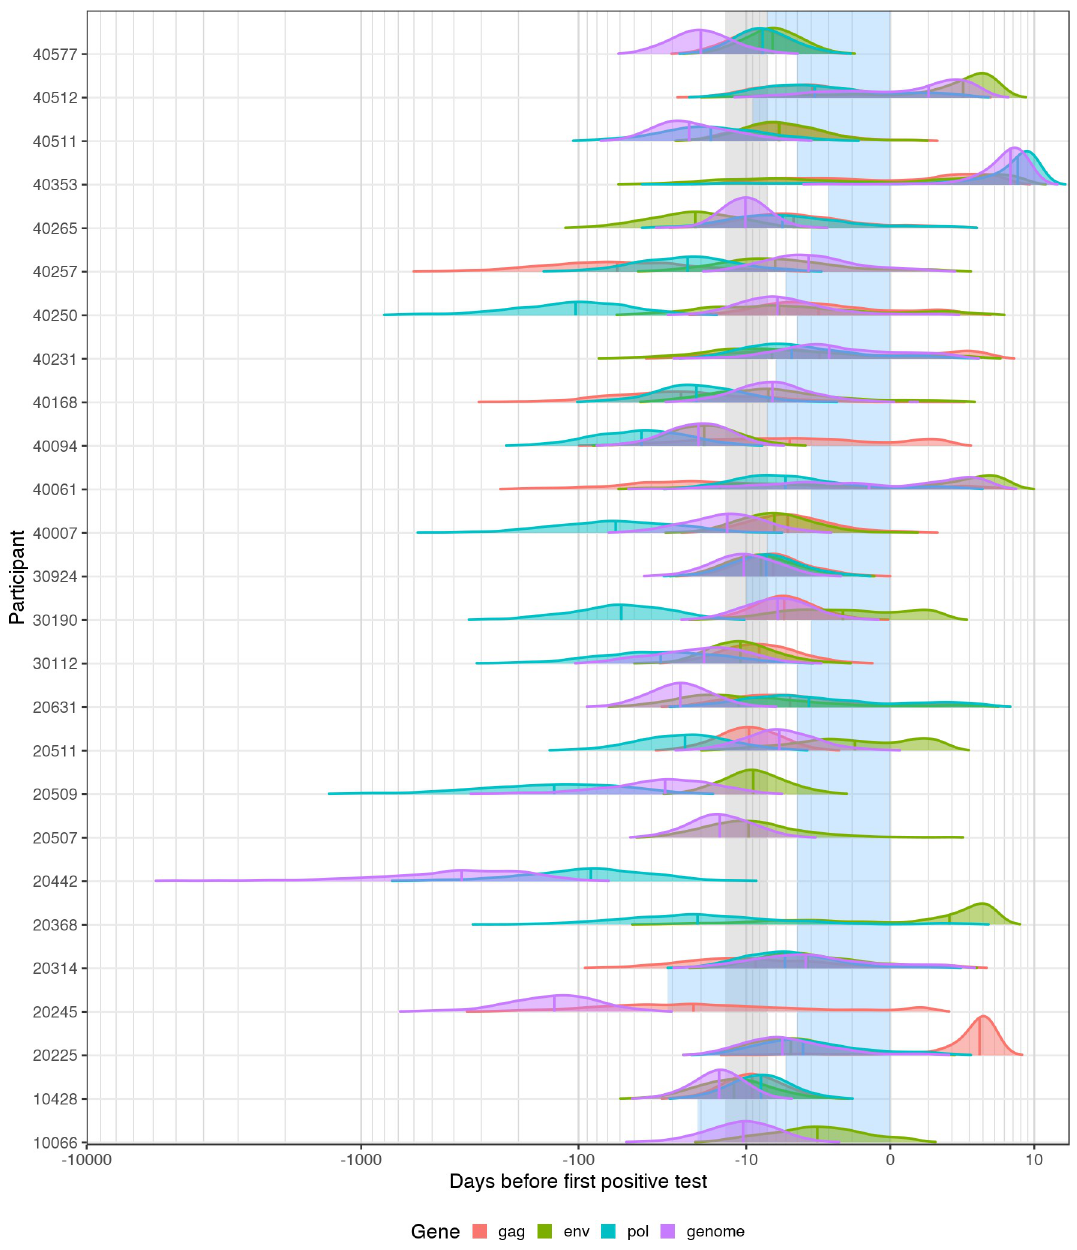
Fig 4. Posterior distributions of the date of infection for participants with a single founder population. Vertical lines mark the median. The shaded blue area corresponds to the interval between the last negative and first positive HIV-1 RNA test (or diagnosis date). The shaded gray rectangle highlights the period between 7 and 14 days before